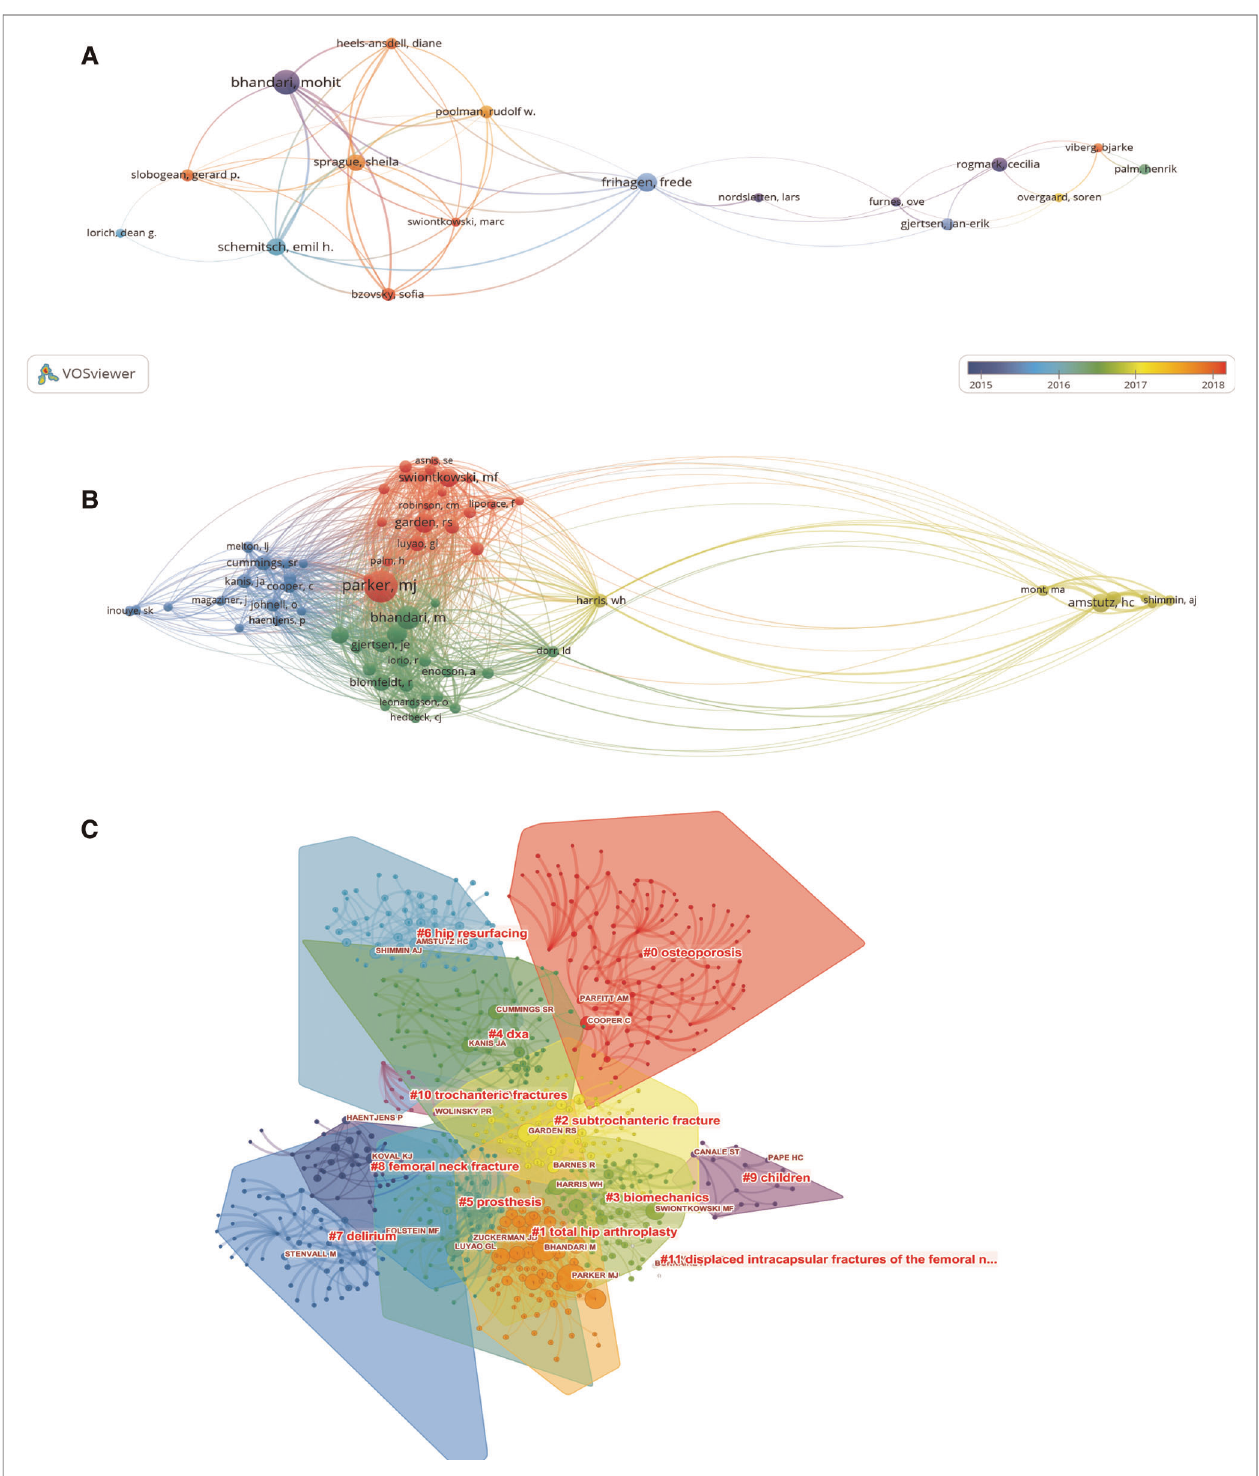
FIGURE 4 | ( A ) Author co-authorship overlay visualization map generated by VOSviewer. Explanations are the same as in Figure 3(A) . ( B ) Network visualization map of author co-citation analysis generated by the VOSviewer. Each node represents a different author, and the node size is proportional to the number of citations. ( C ) In the cluster map, cited authors with similar categories were gathered in a cluster. Twelve clusters with different research topics were formed, re fl ected in different colors on the map (generated by